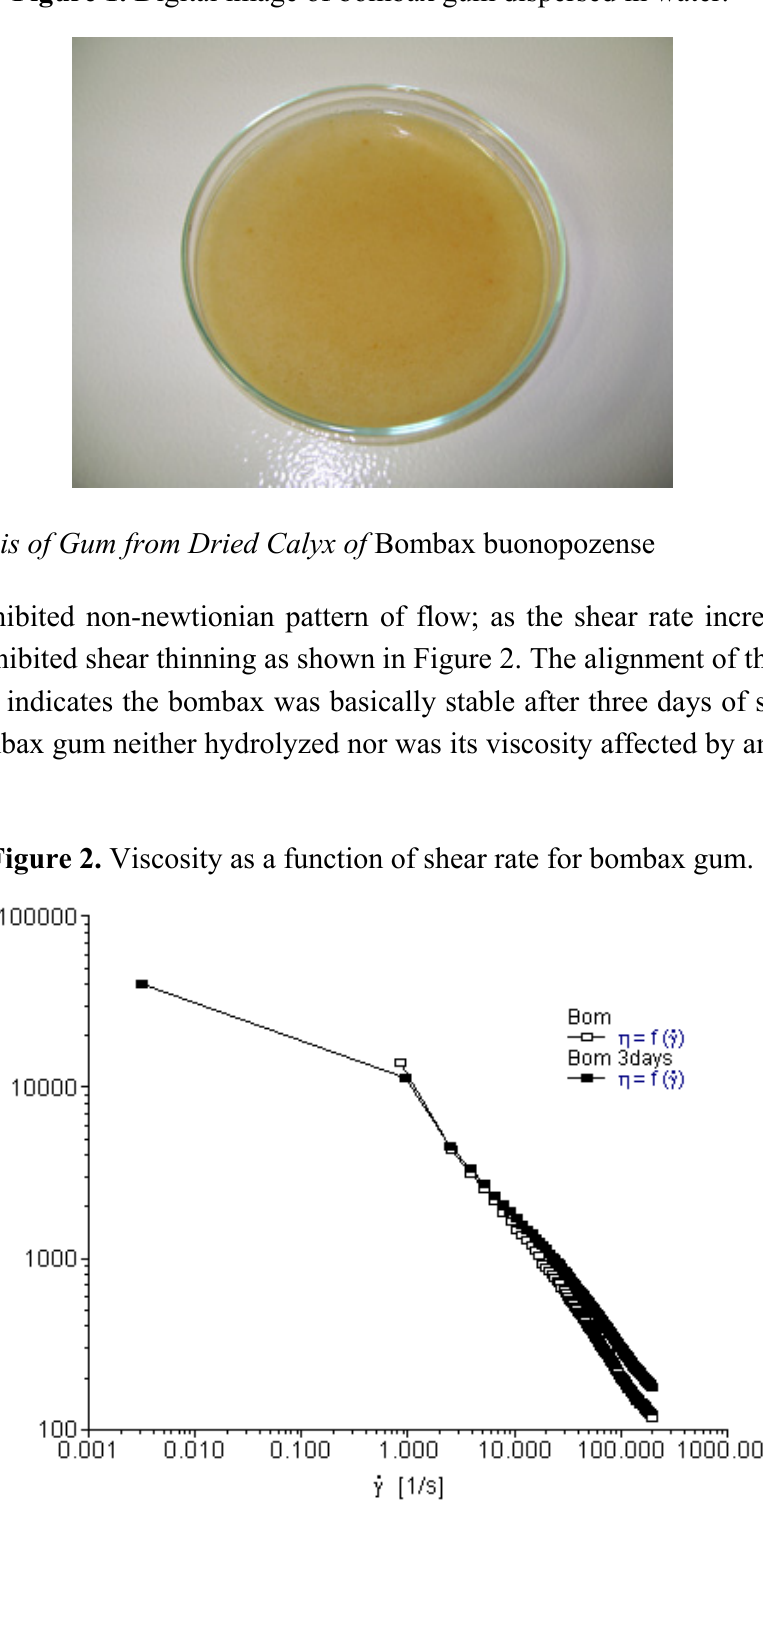
Figure 1. Digital image of bombax gum dispersed in water.